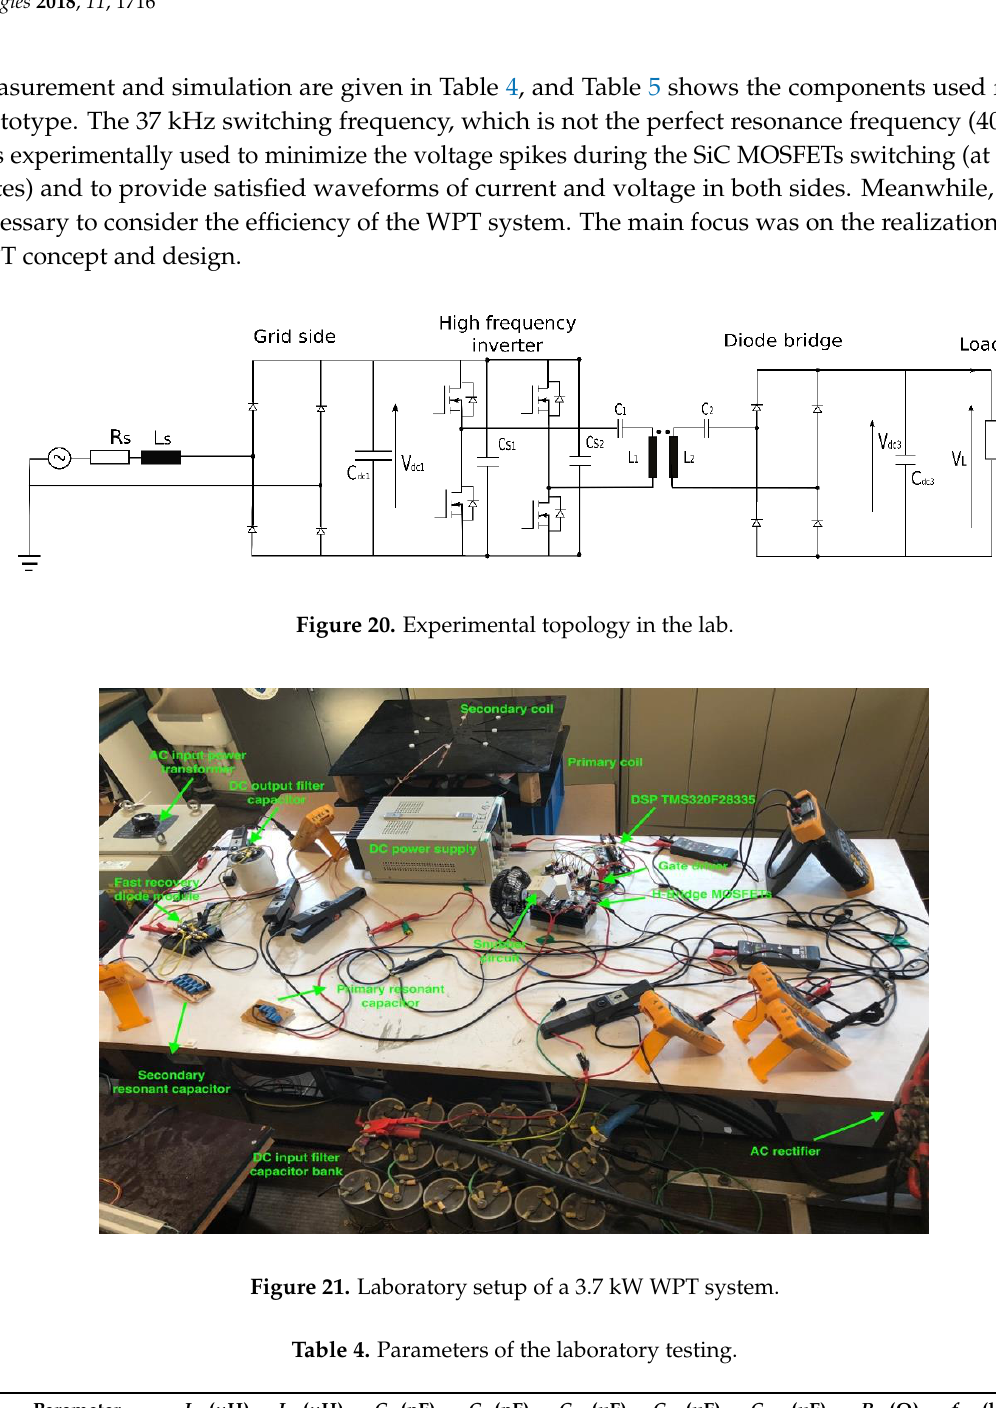
Figure 20. Experimental topology in the lab. Table 4. Parameters of the laboratory testing.